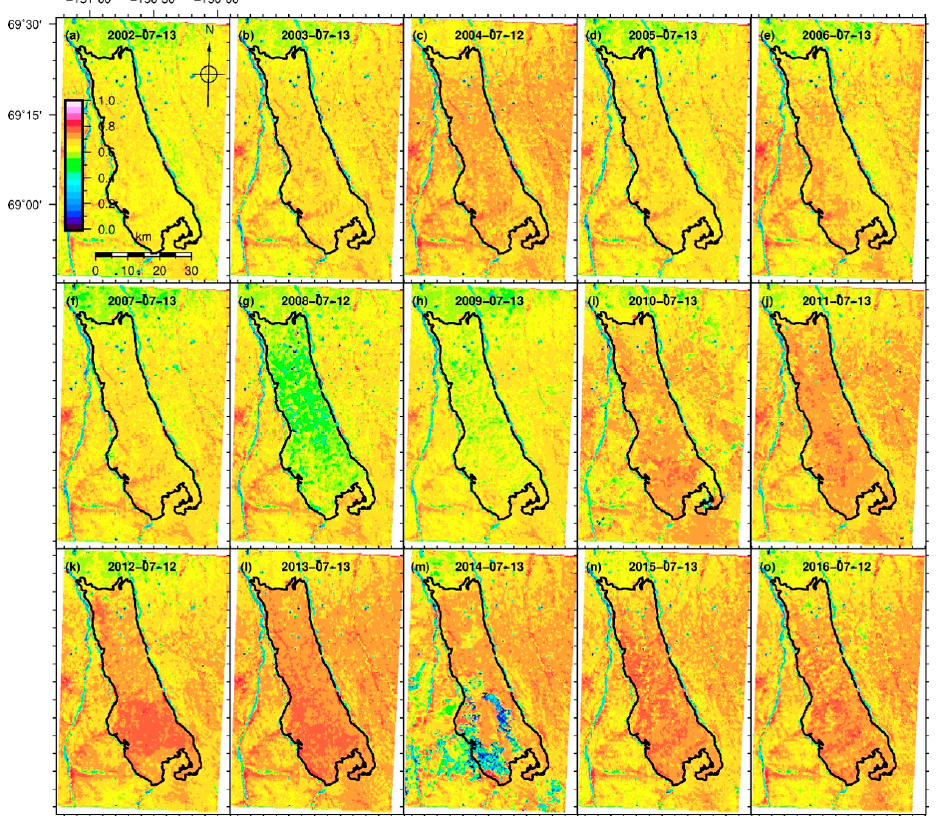
Figure 4. Maps of Normalized Di ff erence Vegetation Index (NDVI) from July 2002 to July 2016. The black polygon in each figure marks the fire boundary. Note that the NDVI image on 13 July 2014 is contaminated by cloud